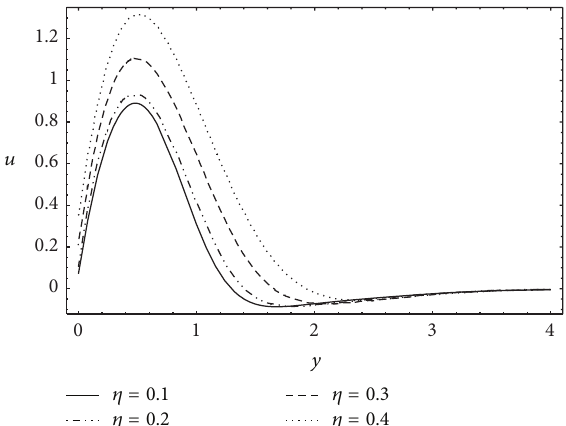
Figure 2: Velocity profiles for different values of 𝜂 corresponding to stepped temperature of the plate with 𝑡 = 0.9 (Pr = 0.71 ).